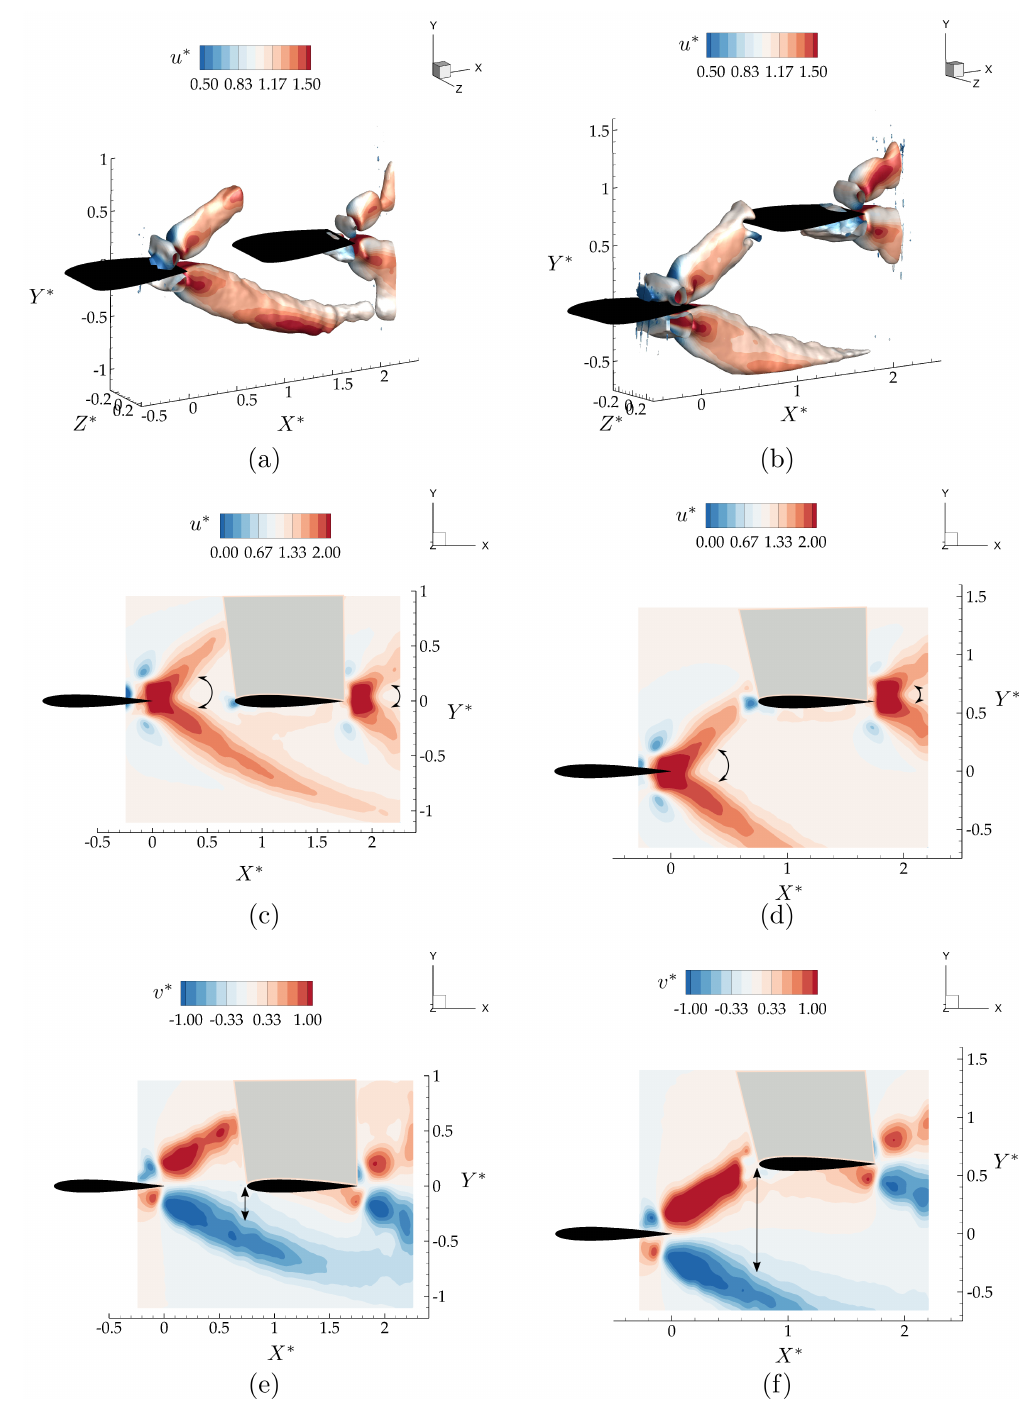
Figure 7. Time-averaged velocity for the in-line arrangement (left column; a , c , e ) and the staggered arrangement (right column; b , d , f ). The top row ( a , b ) presents the | v ∗ | = 0.5 isocontour colored with their corresponding time-averaged velocity, u ∗ . The middle row ( c , d ) presents the time-averaged streamwise velocity at the mid-span plane, while the bottom row ( e , f ) presents the time-averaged cross-stream velocity at the mid-span. Arcs and lines with arrows show the expansion of the streamwise accelerated flow branches, and the distance between the leading edge of the follower and the time-averaged downwash region,